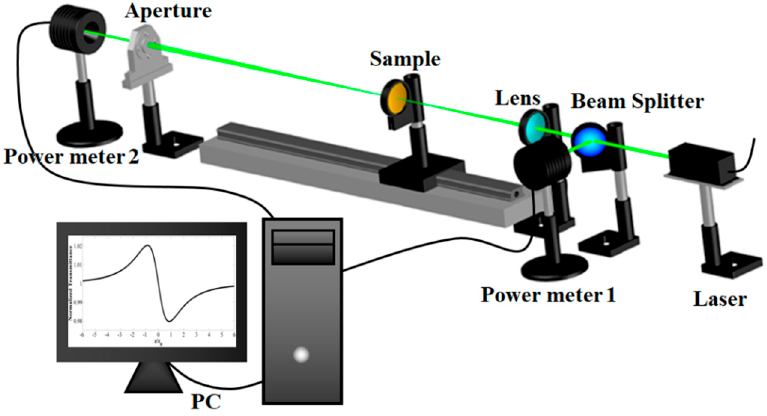
Figure 2. Scheme of the employed Z-scan system for measuring the nonlinear optical (NLO)